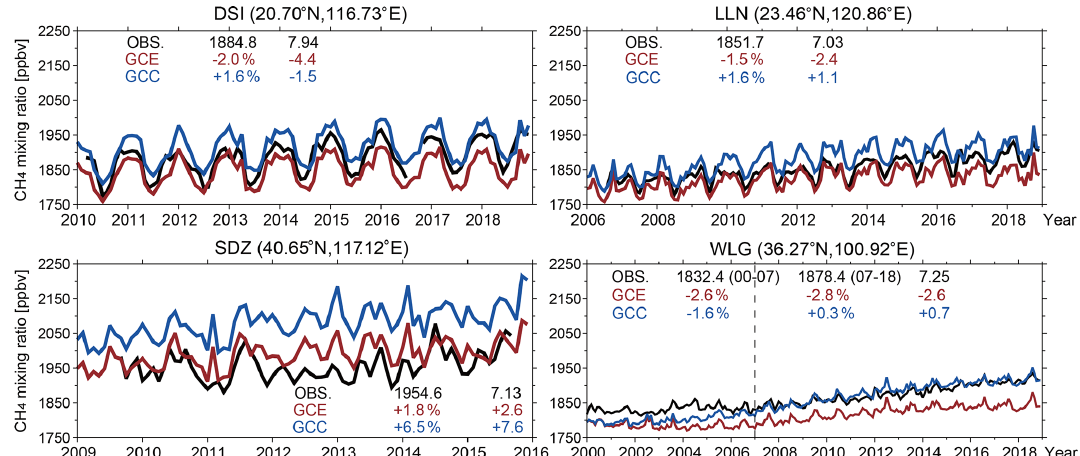
Figure 6. Comparison of GCE-simulated (with EDGAR anthropogenic emissions and interannually varying OH; red lines) and GCC- simulated (with CEDS and interannually varying OH; blue lines) monthly mean CH 4 mixing ratios with NOAA in situ observations (black lines) in China. The observed mean mixing ratios (in unit of ppbv), trends (ppbva − 1 ), and corresponding model biases are shown